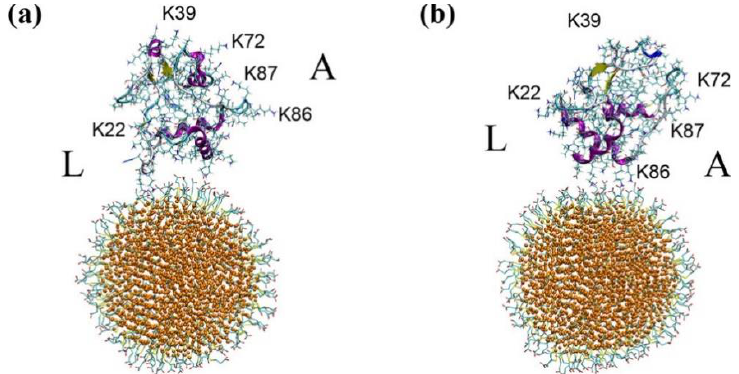
Figure 2. Orientations of cytochrome c adsorbed onto the 4 nm-sized mercaptopropionic acid- functionalized AuNP: ( a ) K22 and K86 facing the NP, ( b ) K86 and K87 facing the NP. Reproduced with permission from [26], American Chemical Society, 2019.